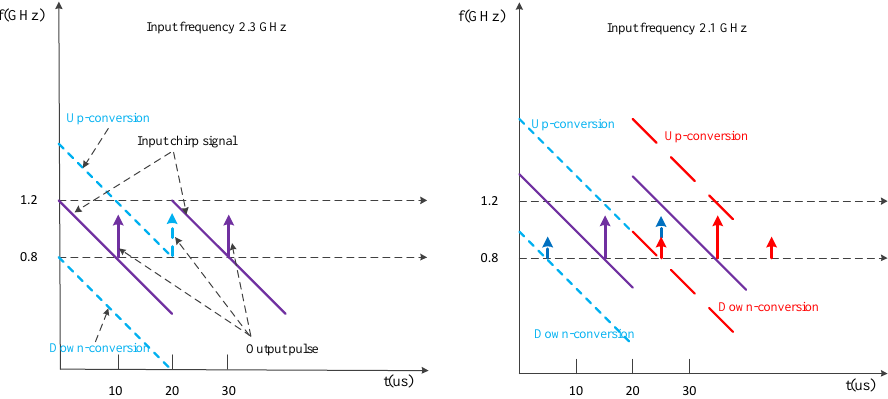
Figure 6. The time–frequency relation between output pulses and input signals. The input signals are firstly modulated by a chirp signal, then multiplied by a mixer to get another two chirp signals. Combination of the three chirp signals will get complete output pulses distribution at each